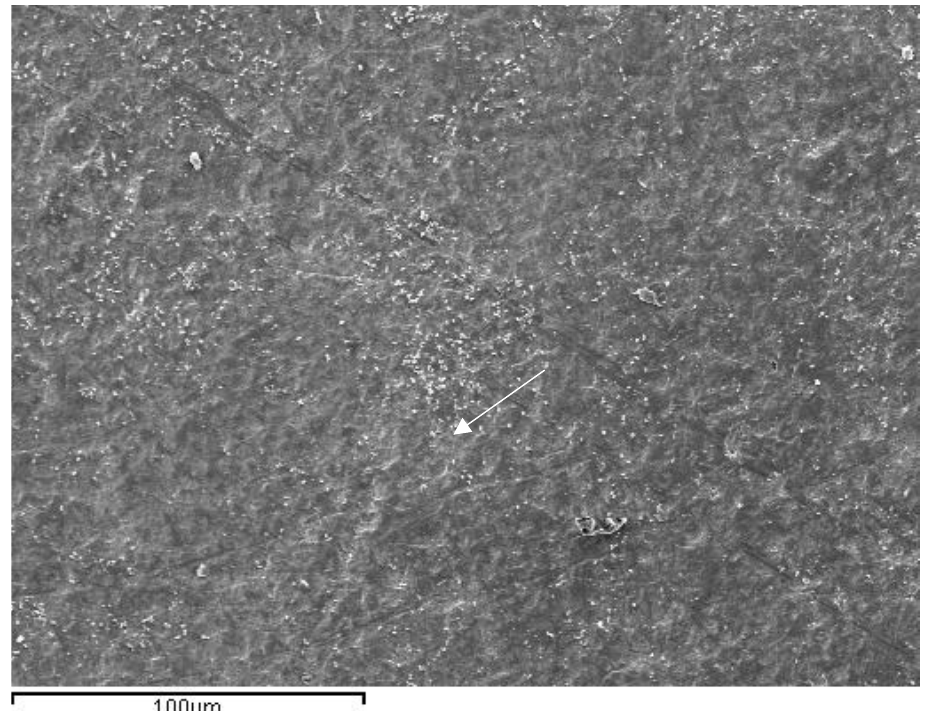
Figure 8. Representative image of enamel of a Group 2 sample after polishing with 30-blade carbide bur at a high speed (arrow points at the most evident indentation of the bur on the enamel surface).